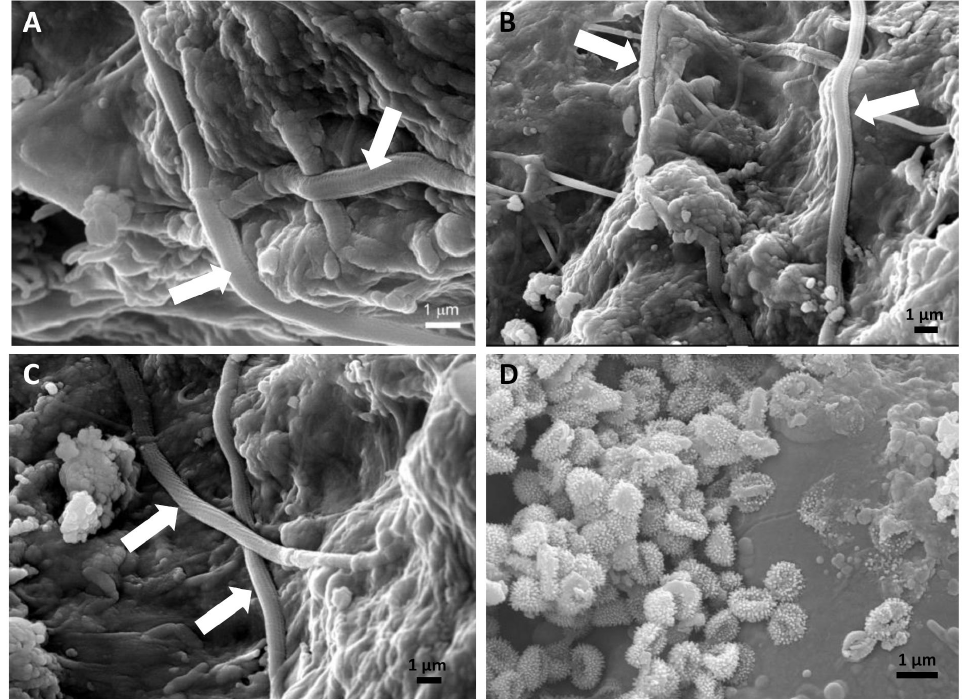
Figure 3. Field emission scanning electron microscopy (FESEM) images of coralloid stalactites (Royal 2) from Royal Palm Cave, showing: ( A – C ) Reticulated filaments embedded in a matrix of extracellular polymeric substances (EPS). ( D ) Clusters of Actinobacteria-like cells with spiny ornamentation. White arrows show reticulated filaments. Magnifications for ( A – D ) are 9000, 5500, 6500 and 10,000,